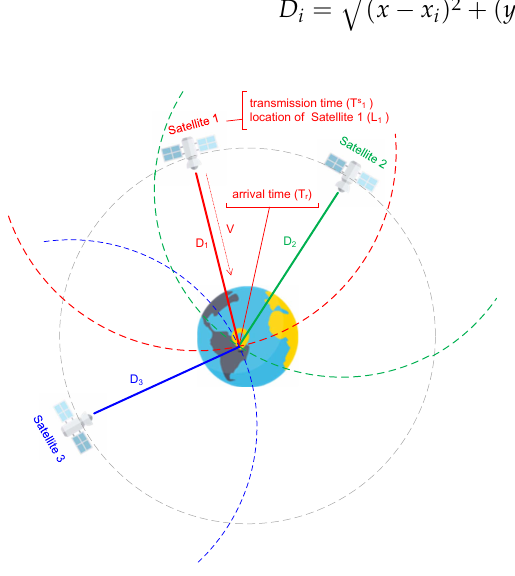
Figure 5. GPS working principle